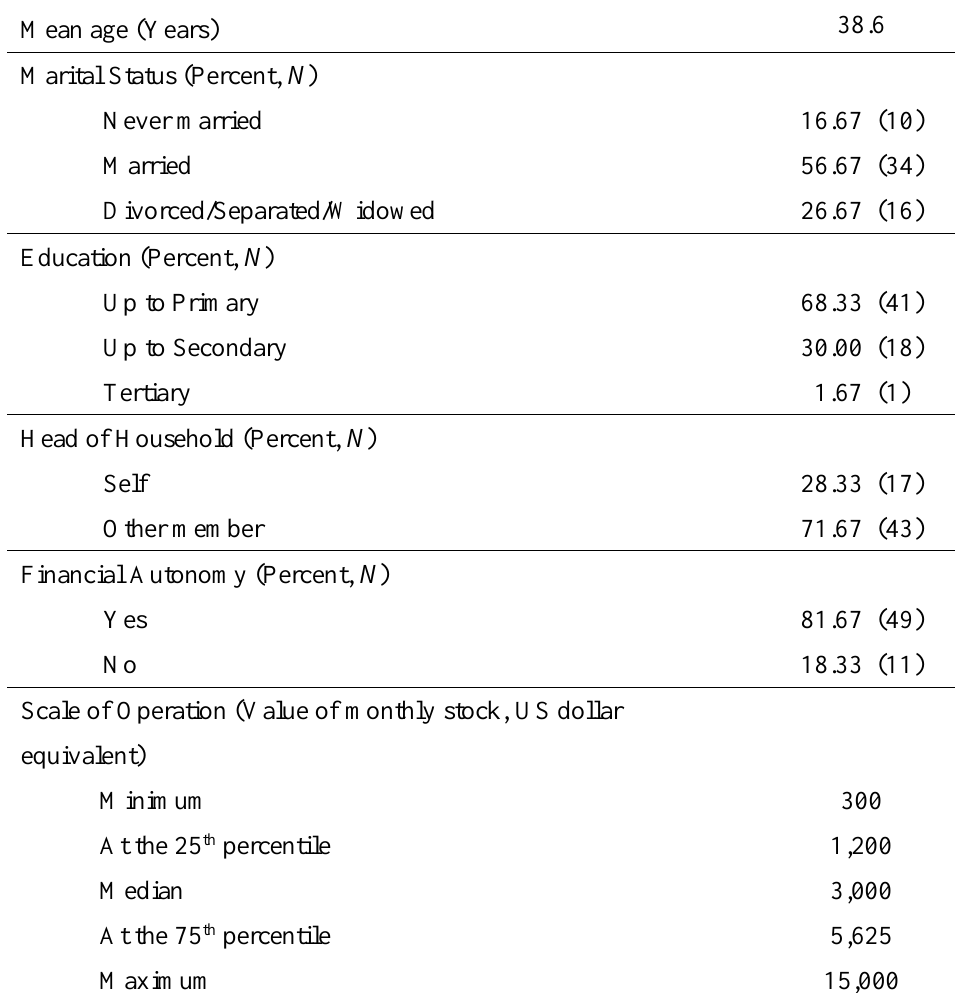
Table 1. Basic Characteristics of Surveyed Market